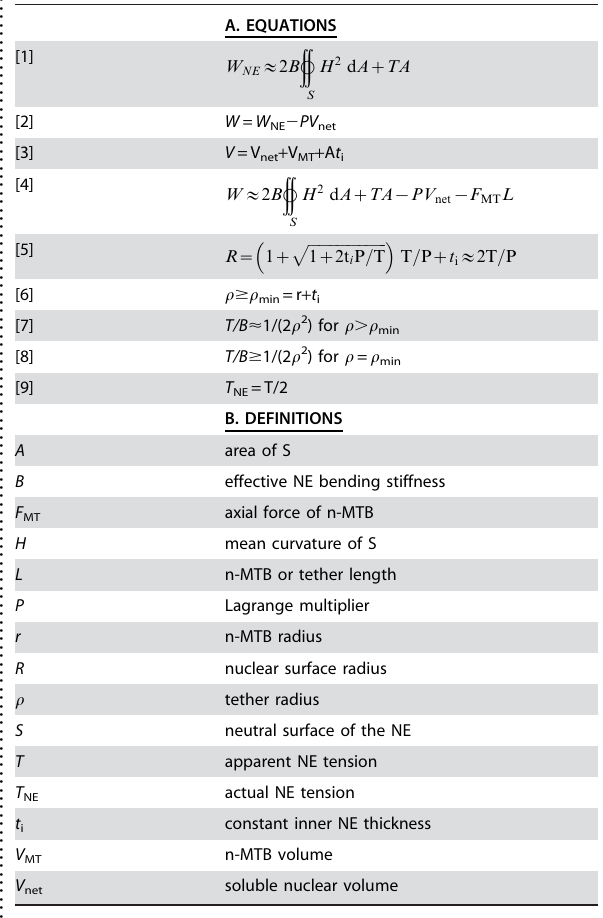
Table 1. Equations (A) and definitions of mathematical symbols (B). .. ... .... ... ... .... ... ... .... ... ... .... ... ... .... ... ... .... ... ... .... .